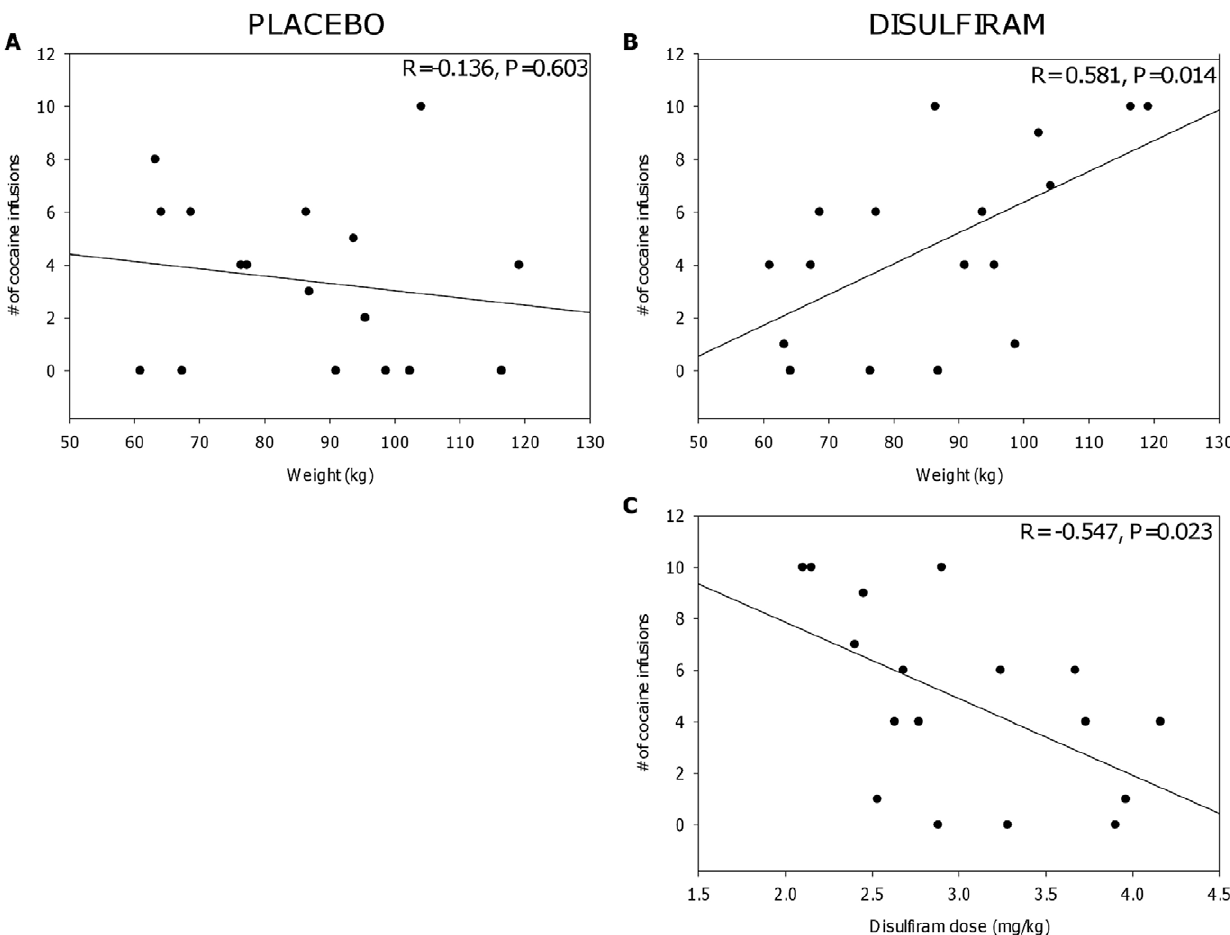
Figure 3. Correlations between weight and number of cocaine infusion choices under placebo and disulfiram treatment conditions. Figure 3A and 3B show the relationship of weight on cocaine choices when treated with placebo and disulfiram. Figure 3C demonstrates the relationship between disulfiram dose calculated on a mg/kg basis and number of cocaine infusion choices under the disulfiram treatment condition. Each data point represents one participant